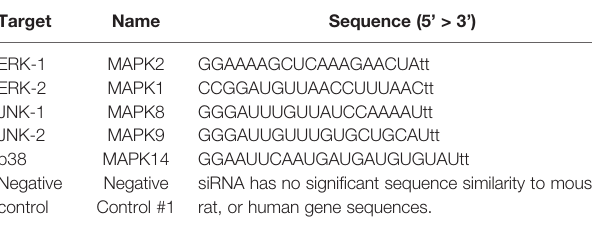
TABLE 1 | The siRNA sequence of MAPK for